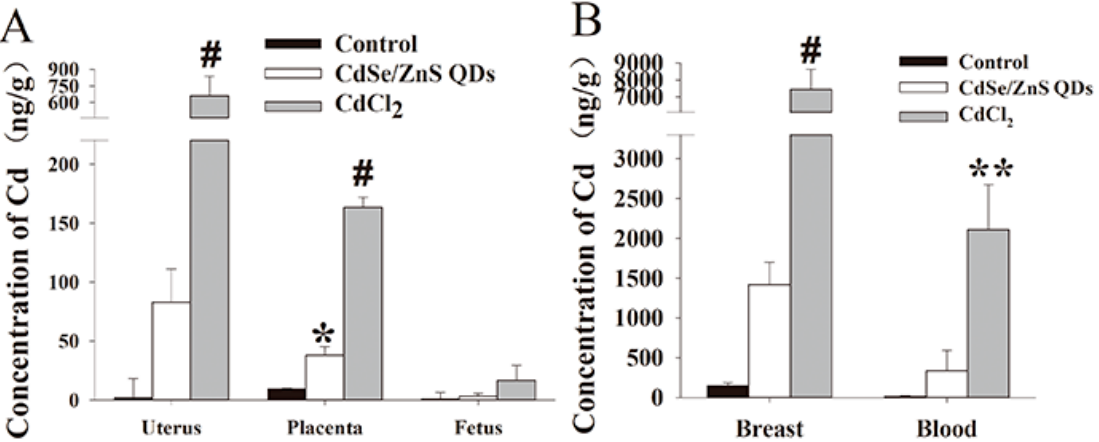
Figure 3. Accumulation of Cd in various organs from different stages of P0 mice. ( A ) uterus, placenta, and fetus in GD 18; ( B ) breast and blood in postnatal day 21 (PND 21). * p < 0.05, ** p < 0.01, # p < 0.001 vs. control. Values were the mean ± standard deviation, n = 5.